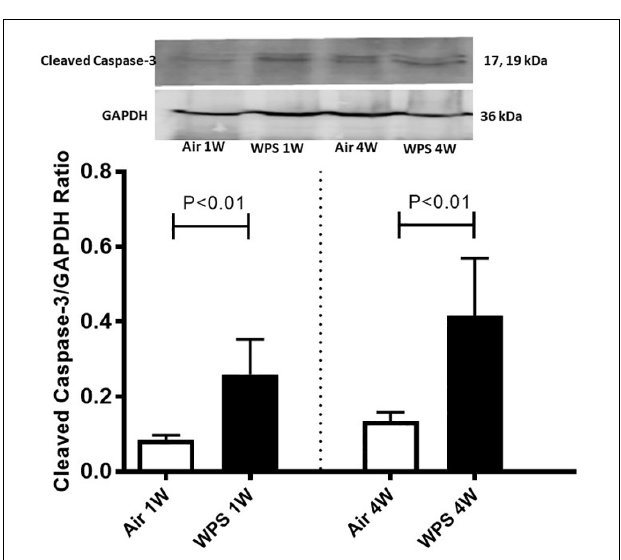
FIGURE 8 | Western blot analysis and graphic representation of cleaved caspase-3 protein levels in the kidney tissues of mice at the end of the 1-week and 4-week exposure periods to air (control) or water-pipe smoke (WPS). Data are mean ± SEM ( n =